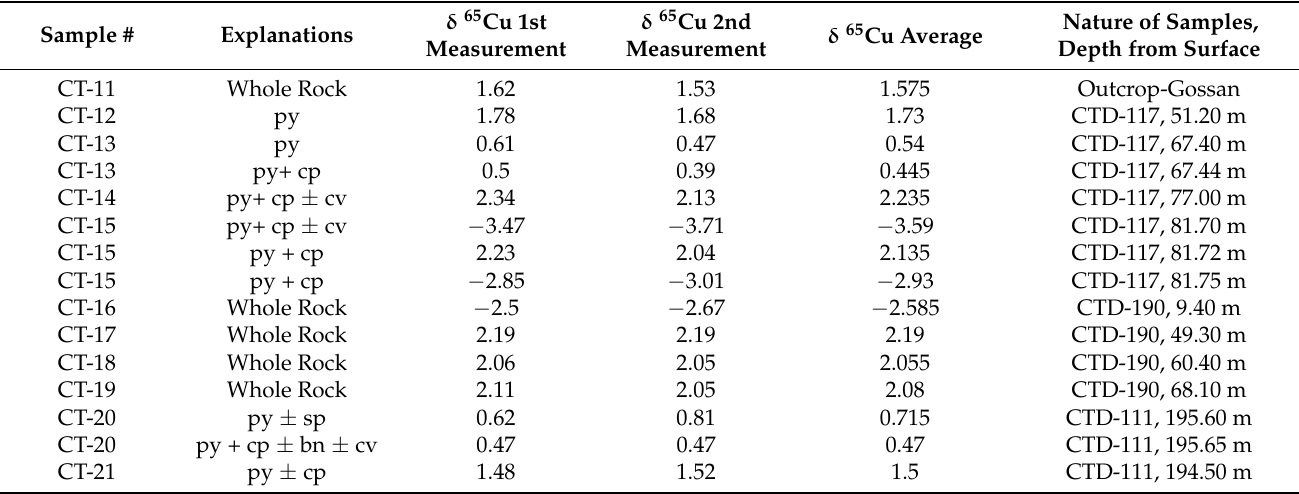
Table 4. δ 65 Cu isotope data of samples from gossan and massive ore zone of Cerattepe VMSD. Each color represents different drill core